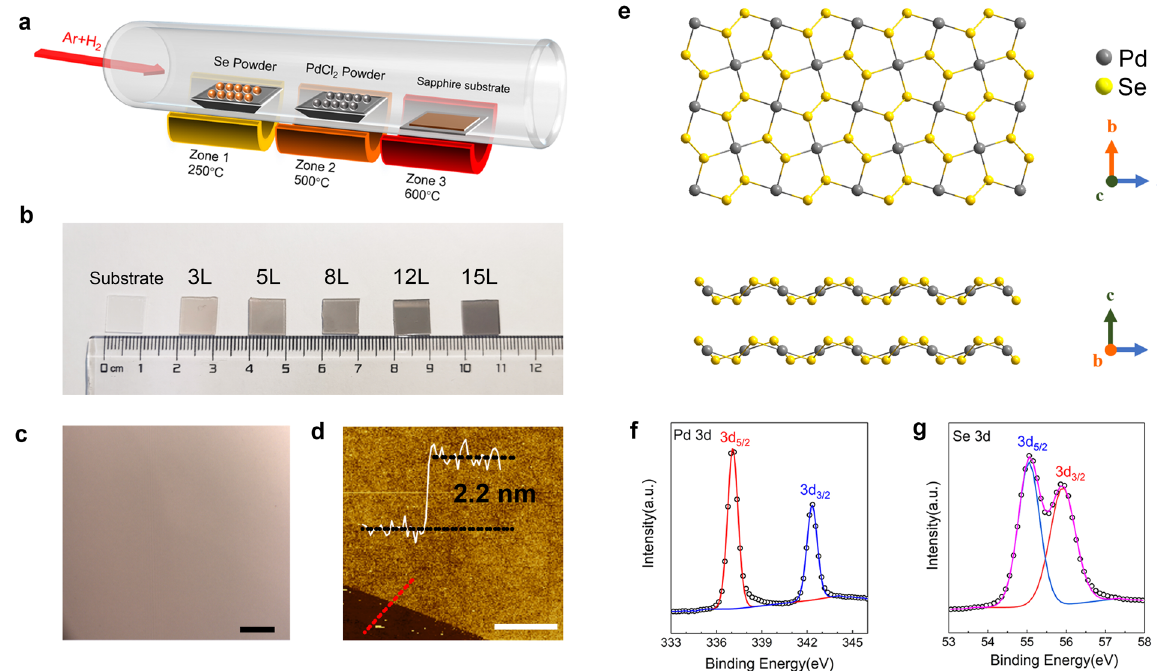
Fig. 1 Synthesis, composition, and morphological characterization of PdSe 2 thin fi lms. a Schematic diagram of three-zone CVD system. b Photographs of PdSe 2 with the different number of layers. c Optical microscope images of 3L PdSe 2 fi lms on a sapphire substrate. The scale bar is 10 μ m. d AFM image of 5L PdSe2 and the high pro fi les across the solid white line. The scale bar is 5 μ m. e The schematic illustration of PdSe 2 crystal from top view (up image) and side view (bottom image). f , g XPS spectrum of Pd 3d and Se